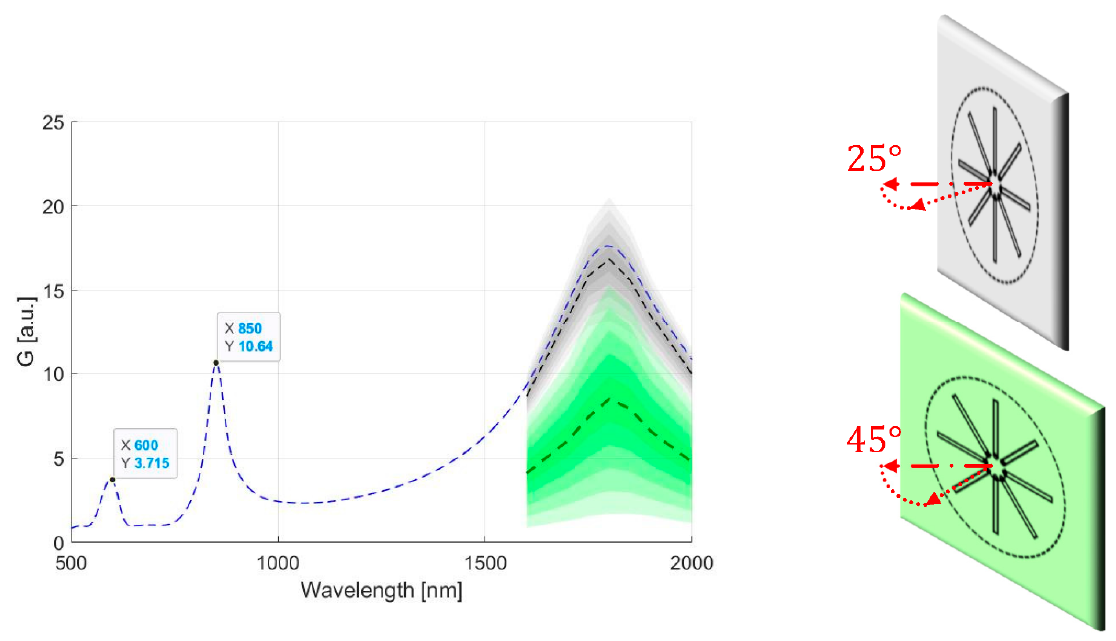
Figure 5. The figure of merit for the reference antenna, and its performance as a function of the angle between the propagation vector and antenna plane. Blue represents the normal incidence; black is 22.5 ◦ , and green is 45 ◦ . The blurred area illustrates the gain variability where the inset color (gray and green) shows the corresponding angle between the propagation vector and the antenna